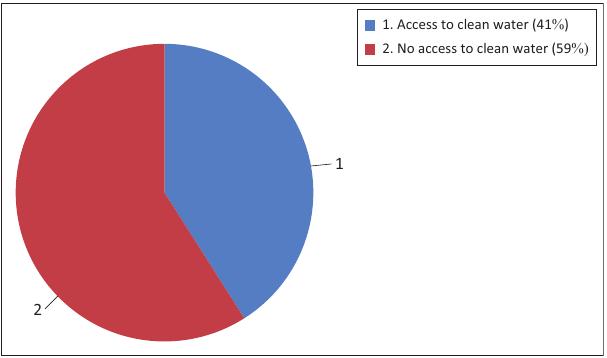
FIGURE 1: Percentage of people accessing clean water in